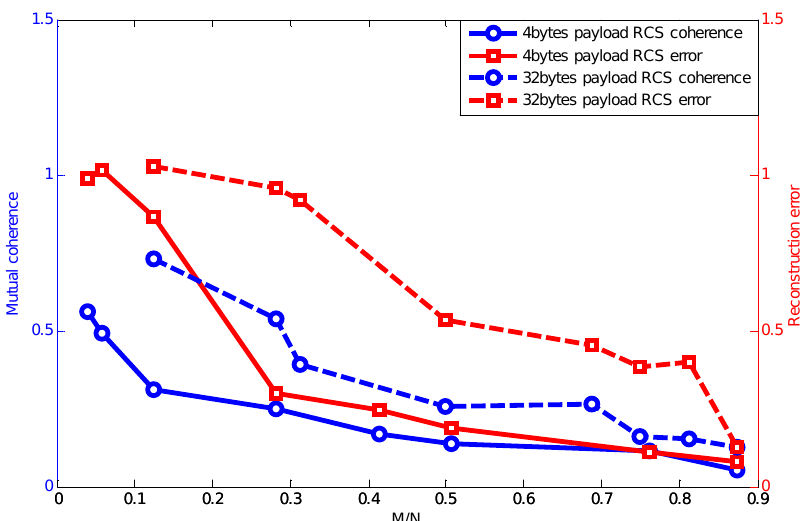
Figure 23. Mutual coherence and recovery error comparison with different packet